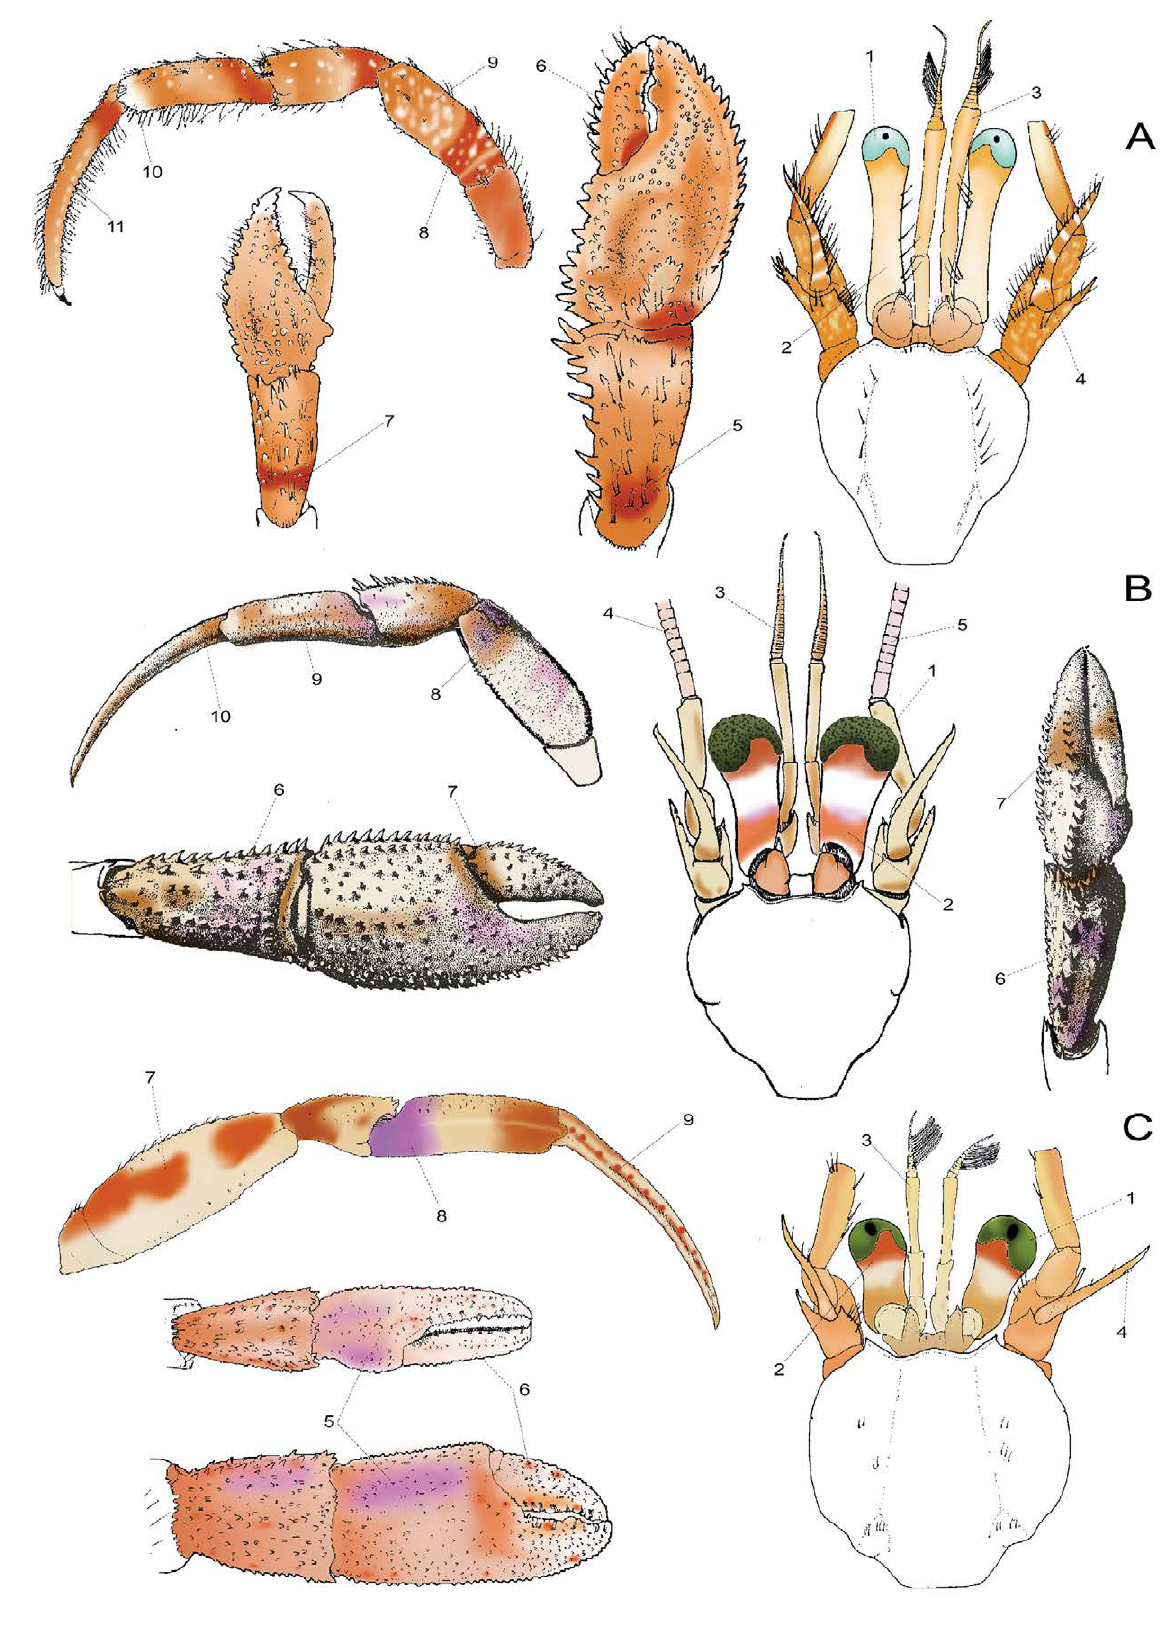
Fig. 10. – Colour patterns of Pagurus species: P. forbesii (A, 1-11); P. mbizi (B, 1-10); P. prideaux (C, 1-9). Vectorial drawings modified from A, C, Ingle (1993); B, Forest